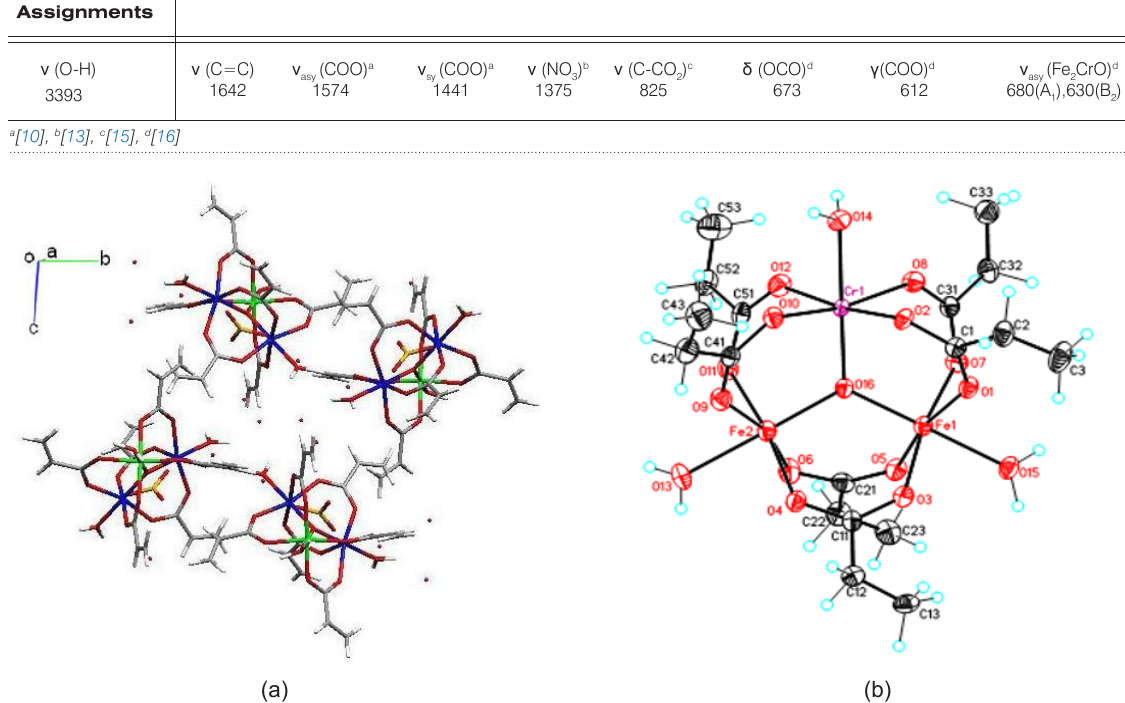
Figure 3. Molecular structure and atomic labeling of the mixed metal trinuclear complex [Fe